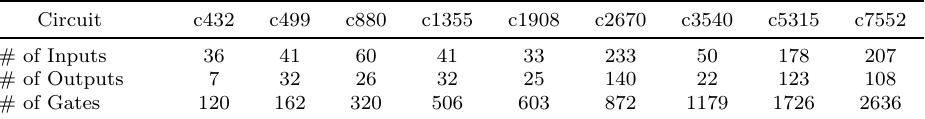
Table 2: ISCAS-85 Benchmarks and Their